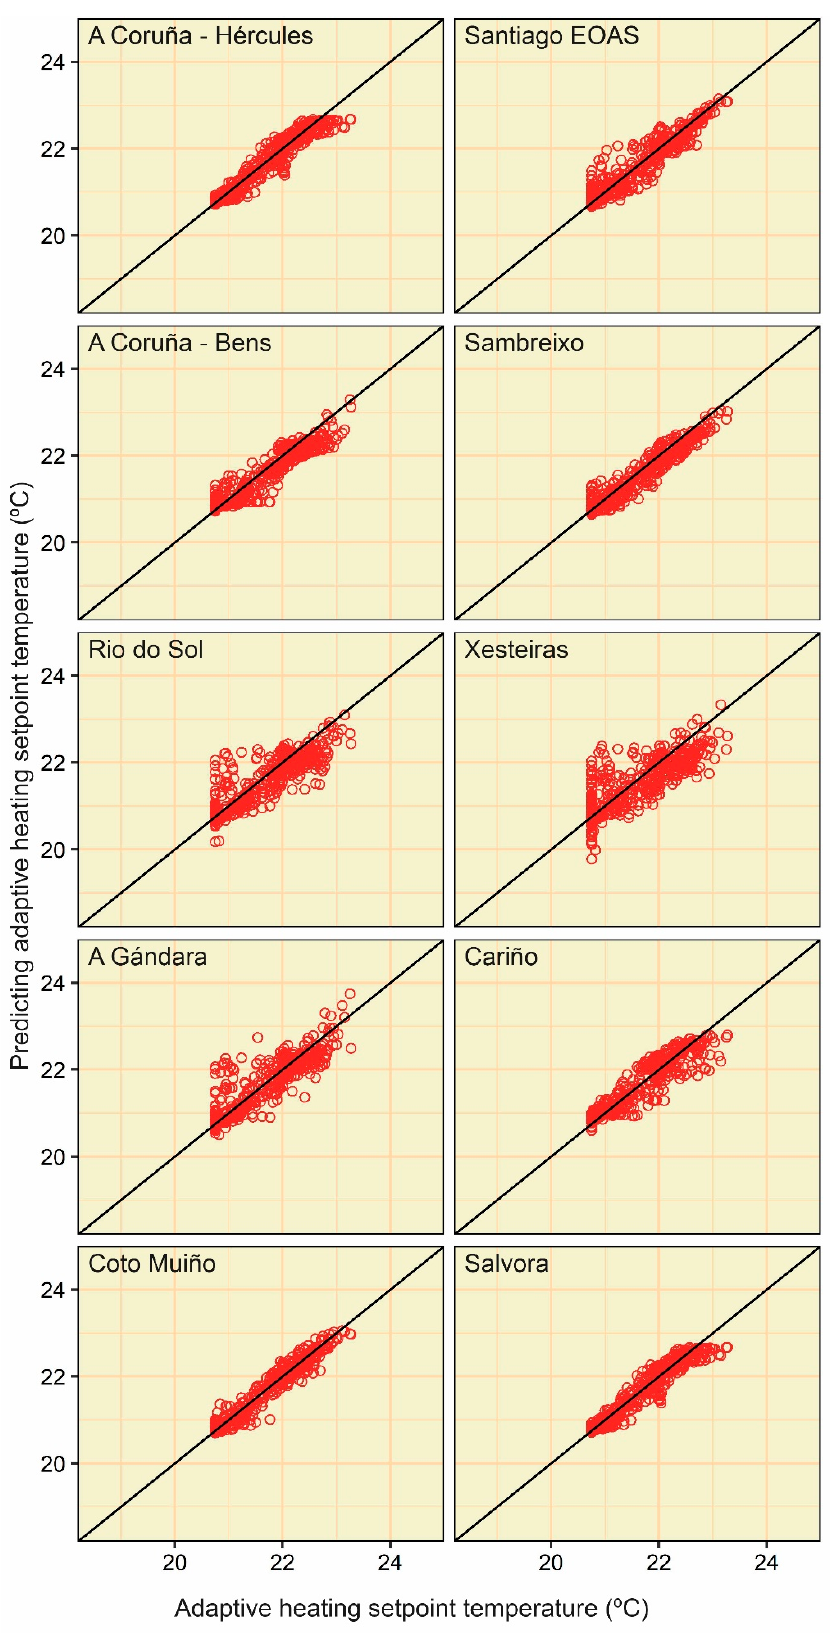
Figure A23. Point clouds between the actual and predicting adaptive heating setpoint temperature values (category II) of the MLP (approach 2).